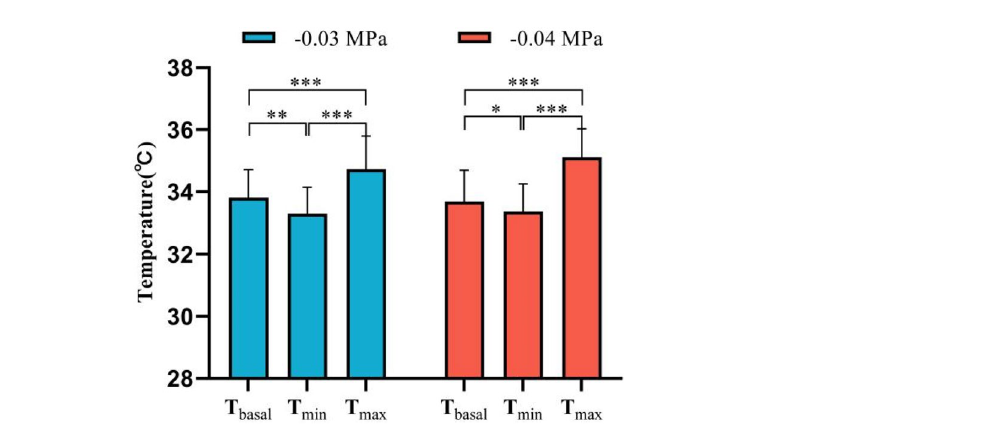
Figure 6. Comparison of T basal , T min , and T max (mean ± SD). *P < 0.05; **P < 0.01; ***P < 0.001.